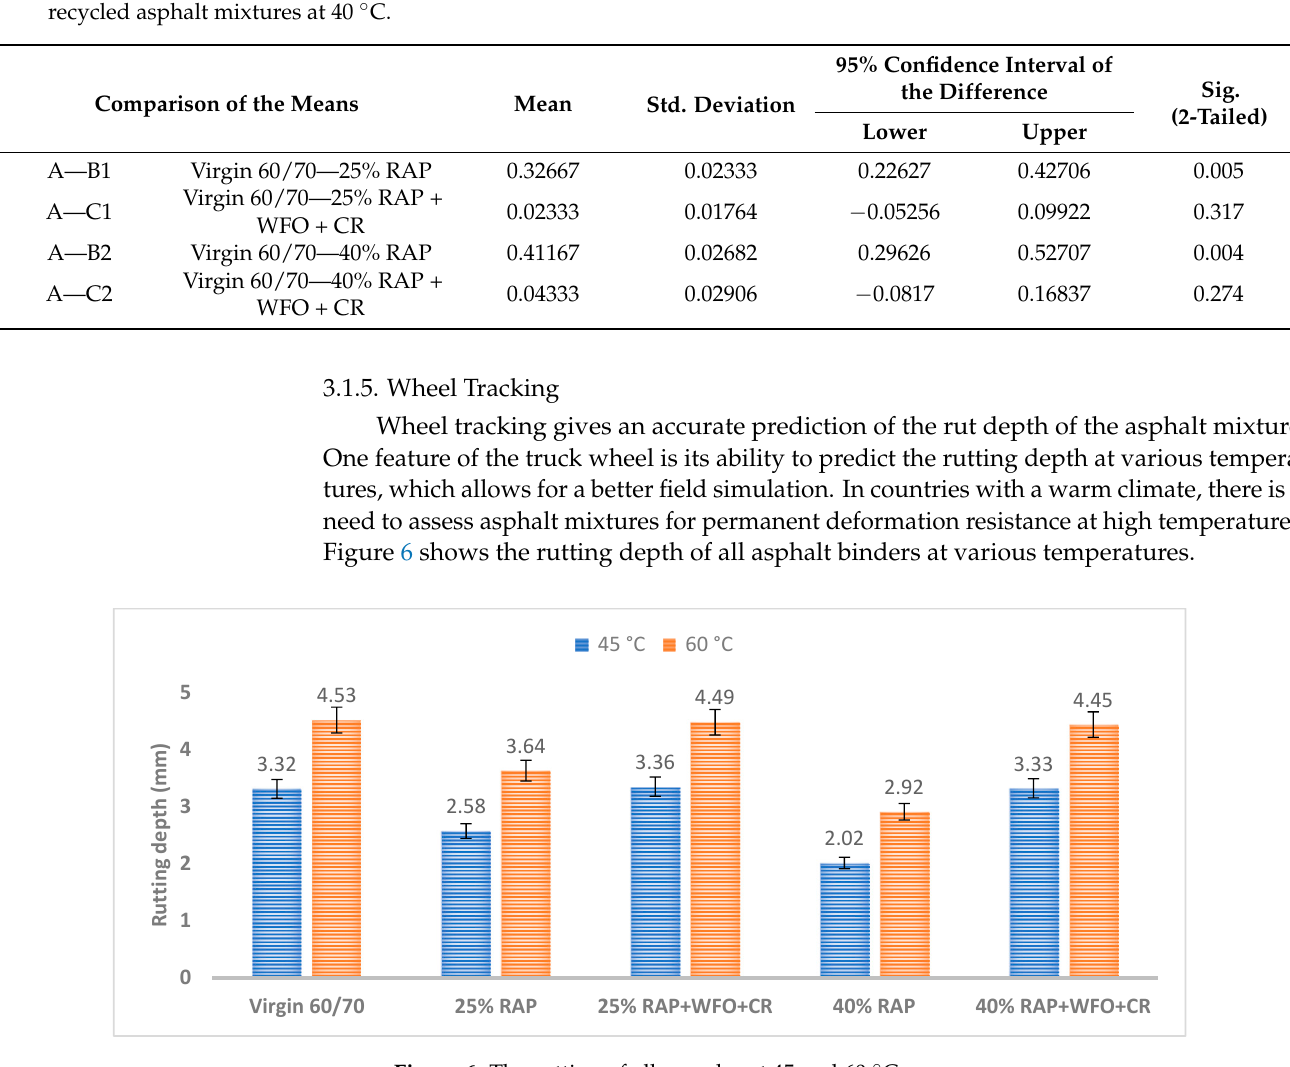
Figure 6. The rutting of all samples at 45 and 60 °C. Table 19. The significant difference in the group means for the rutting of the virgin asphalt with RAP and the recycled asphalt mixture at 45 °C.